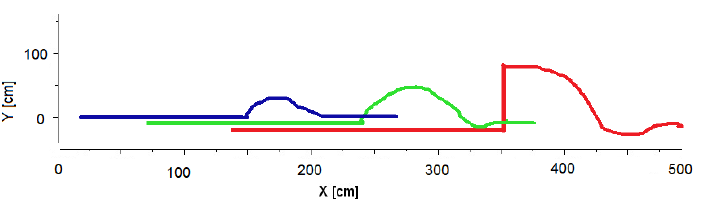
Figure 16. Trajectories of the quadrotors in Experiment 2 when neither catenary–parabola approxi- mation nor the online AFM tuning of the PD controllers are applied. Color code: red, green and blue correspond to leader, mid and rear drones.